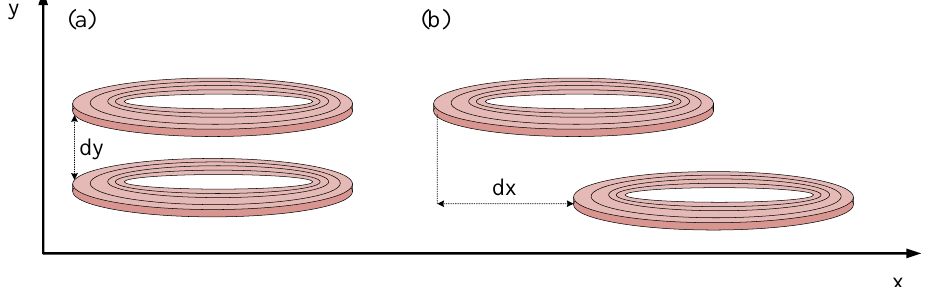
Figure 8. Arrangement of the transmitting and receiving coils: horizontal position ( a ), vertical position ( b ).